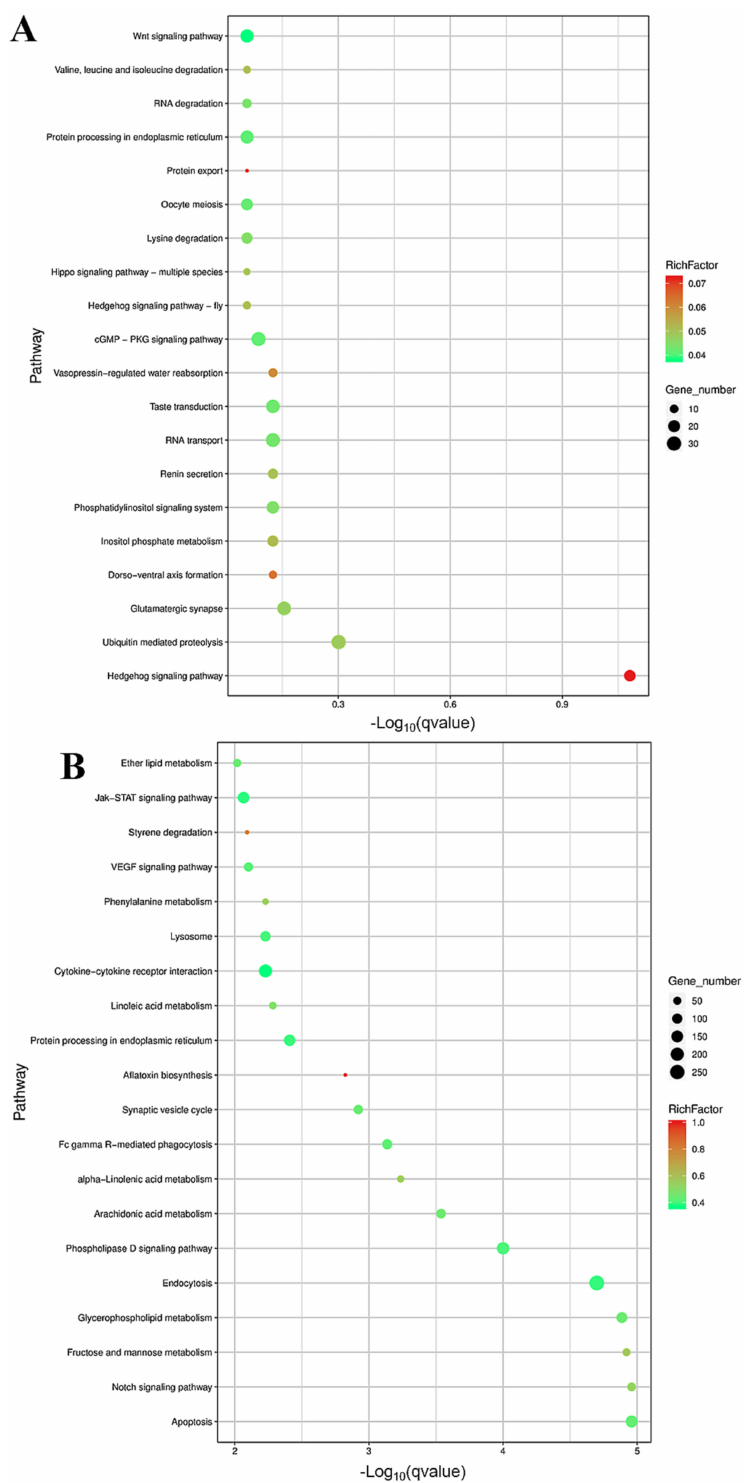
Figure 6. The top 20 enriched KEGG for the identified DEGs and target genes of the DEMs in the LP- HF vs LP-LF. The X-axis and Y-axis represent the -log 10 ( q value) of the enriched genes and the KEGG pathways, respectively. Rich factor refers to the ratio of the number of the differentially expressed gene and the number of the annotation genes enriched in this pathway term. The size of the circle in the figure indicates the number of the differential gene enrichment in the pathway. KEGG; Kyoto encyclopedia of genes and genomes. ( A ) KEGG enrichment pathways for the DEGs in the LP-HF vs LP-LF. ( B ) KEGG enrichment pathways for the target genes of the DEMs in the LP-HF vs